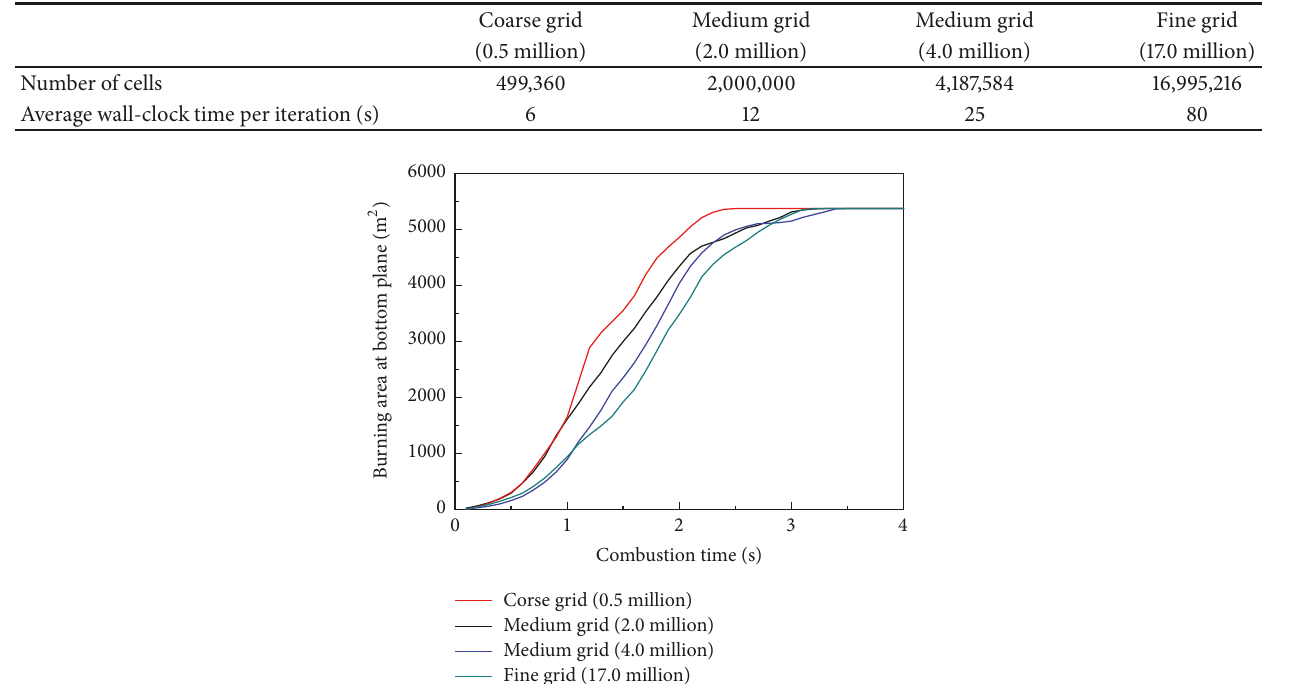
Table 1: Number of cells and average wall-clock time per iteration of different grid resolutions.